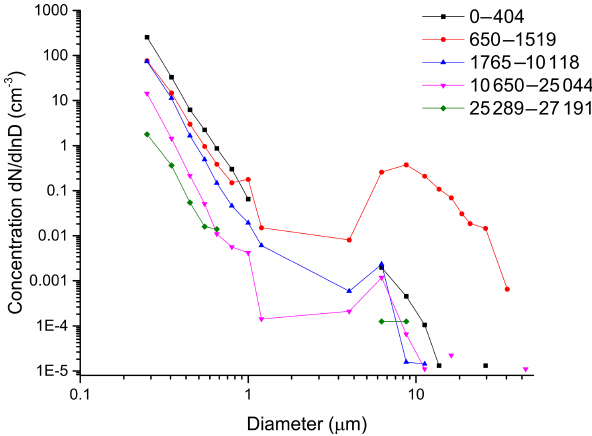
Figure 4. Average size distribution of aerosol particles at various height layers during the BEXUS18 stratospheric flight. The five curves are obtained by averaging the aerosol number densities as a function of the atmospheric layers pointed out by the tempera- ture profile as follows: 1: 0–404m (black line); 2: 650–1519m (red line); 3: 1765–10118m (blue line); 4: 10650–25044m (pink line); 5: 25289–27191m (green line). x and y axes are in log-normal